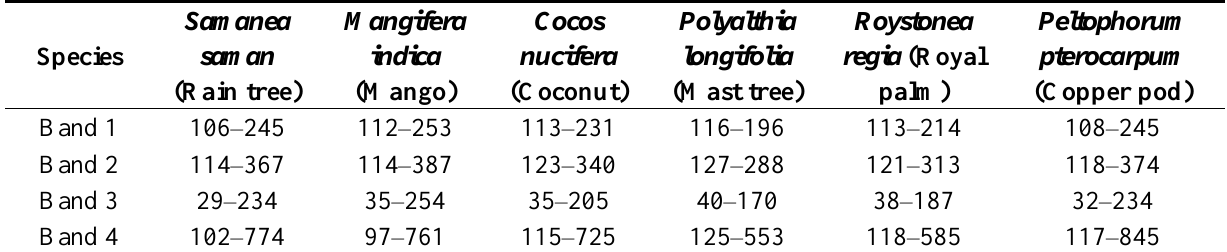
Table 1. Range in band reflectance exhibited for each tree